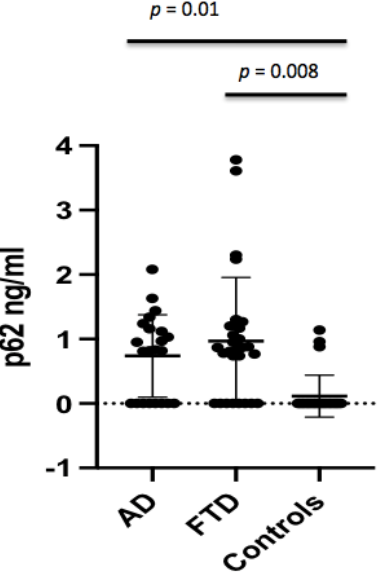
Figure 1. Comparison of CSF p62 concentrations between AD, FTD, and control groups after adjusting for age.